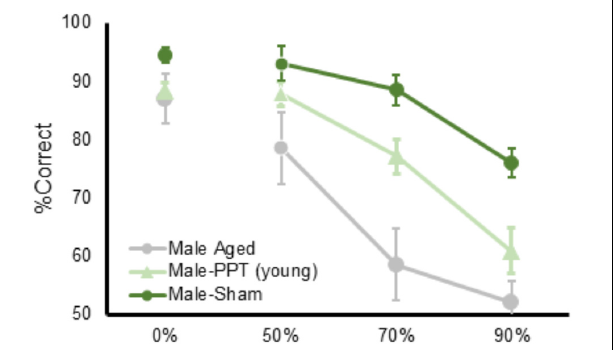
FIGURE 6 | A comparison of the PPT rat mnemonic discrimination task performance compared to aged rats. Percent correct ( Y -axis) as a function of target-lure similarity ( X -axis) for rats from the current study plotted against young and aged rats tested in Johnson et al. (2017). The impairment following perforant path transection does not match the magnitude of the deficit previously observed in aged